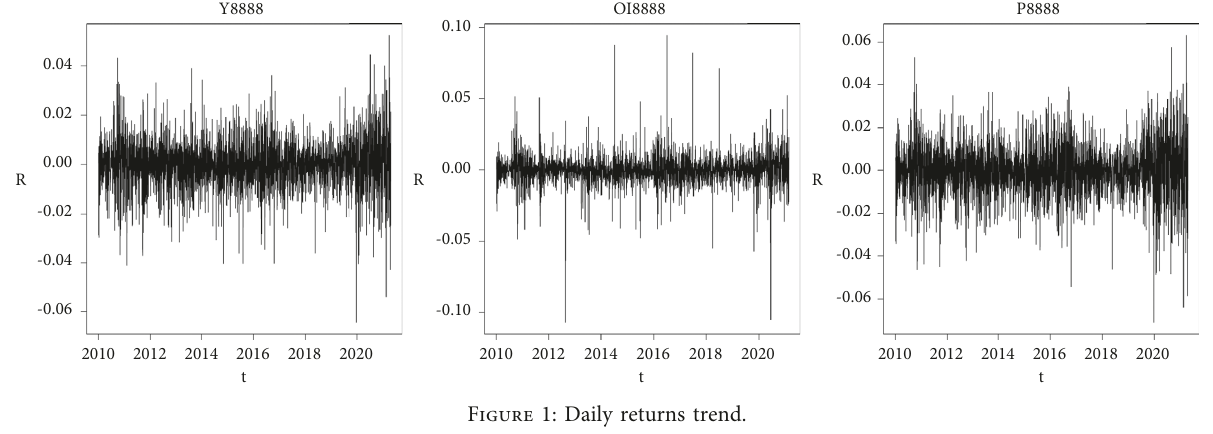
Figure 1: Daily returns trend.